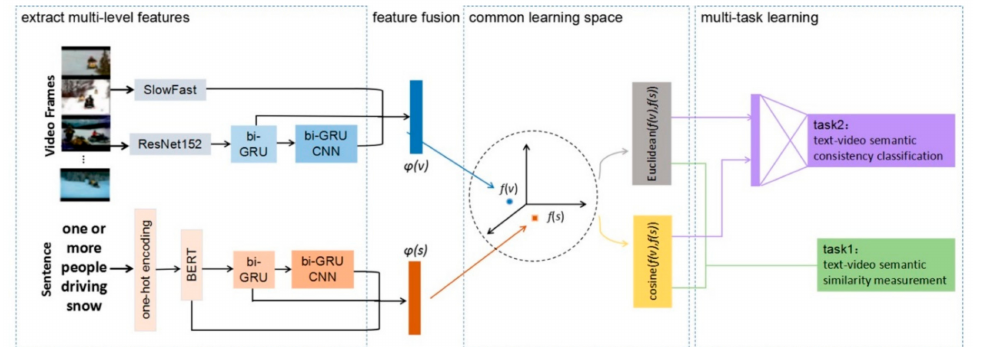
Figure 3. The framework of our method in this paper. By using dual multi-level encoder, we fully learn the multi-modal features, and then map them into the common learning subspace, and the cross-modal similarity is calculated to complete the retrieval task. At the same time, the text-video sample pairs are classified through the full connection layer to form a multi-task learning